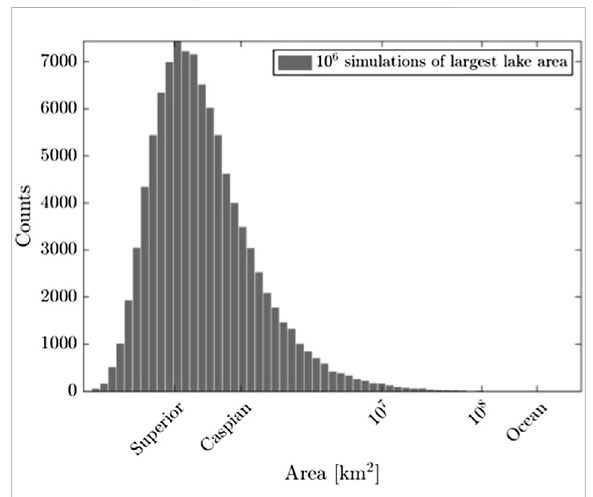
FIGURE 2 Histogram of 1,000,000 simulated values for the area of Earth ’ s largest lake, based on the total number of Earth ’ s lakes > 1 km 2 and the power-law exponent of Earth ’ s lakes (excluding the Caspian Sea and Lake Superior). X-axis shows the area of the Caspian Sea and Lake Superior. Note that 1 km 2 = 10 6 m 2